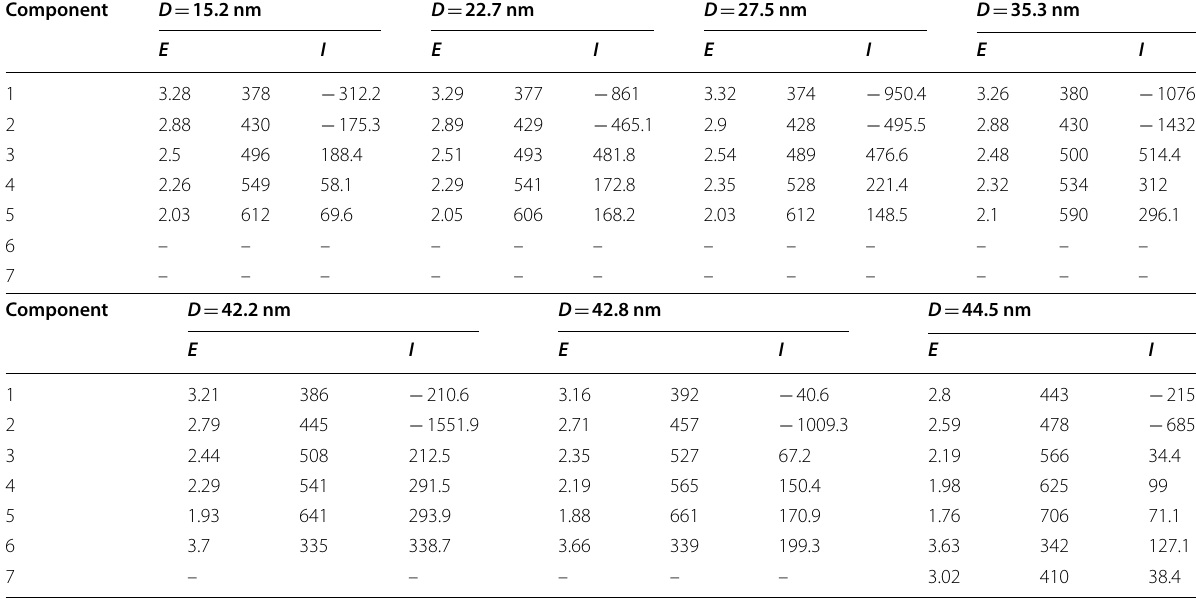
Table 3 Peaks position ( E , in eV and nm) and peaks intensity ( I , arb. unit) of the Gaussian components obtained from MCD spectra analysis